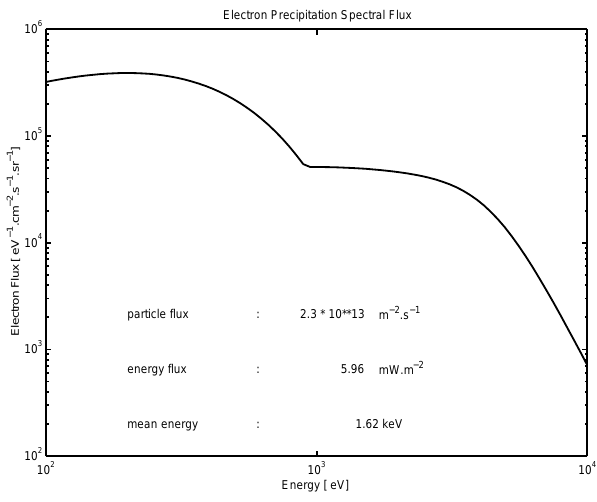
Fig. 1. Spectral flux of the precipitating